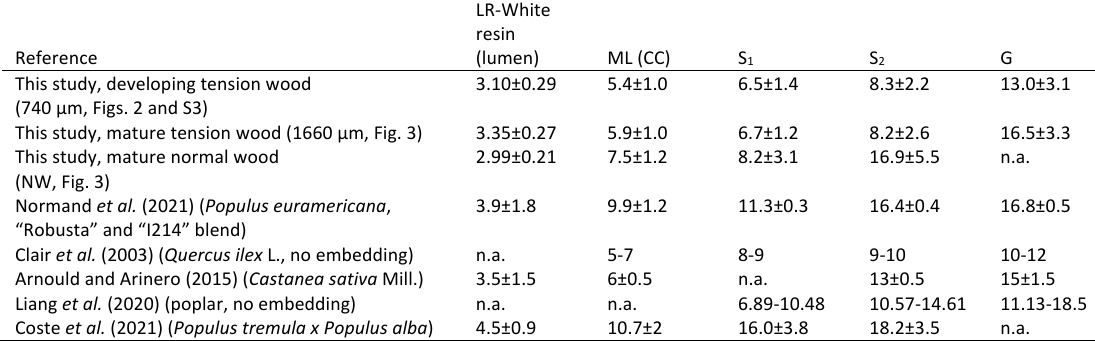
Table 1 : Comparison of the value of the indentation modulus (in GPa) in the different layers of developing and mature wood fibres in our study and in the